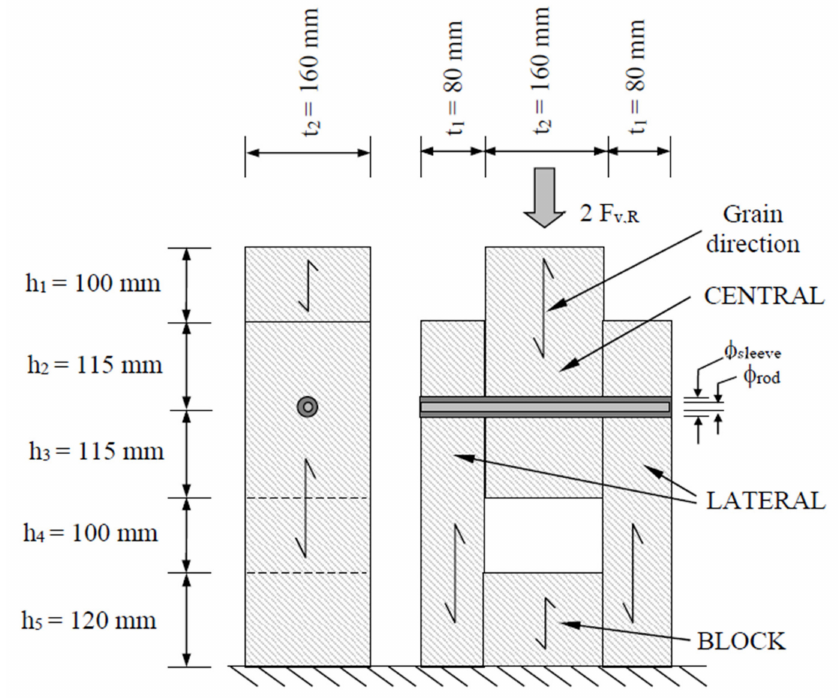
Figure 1. Geometry of the